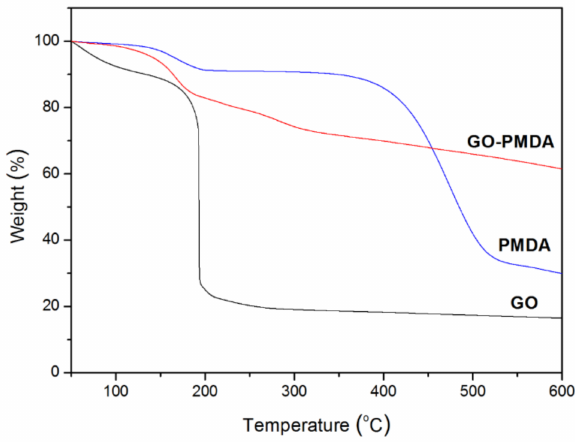
Figure 5. TGA curves of GO, PMDA, and